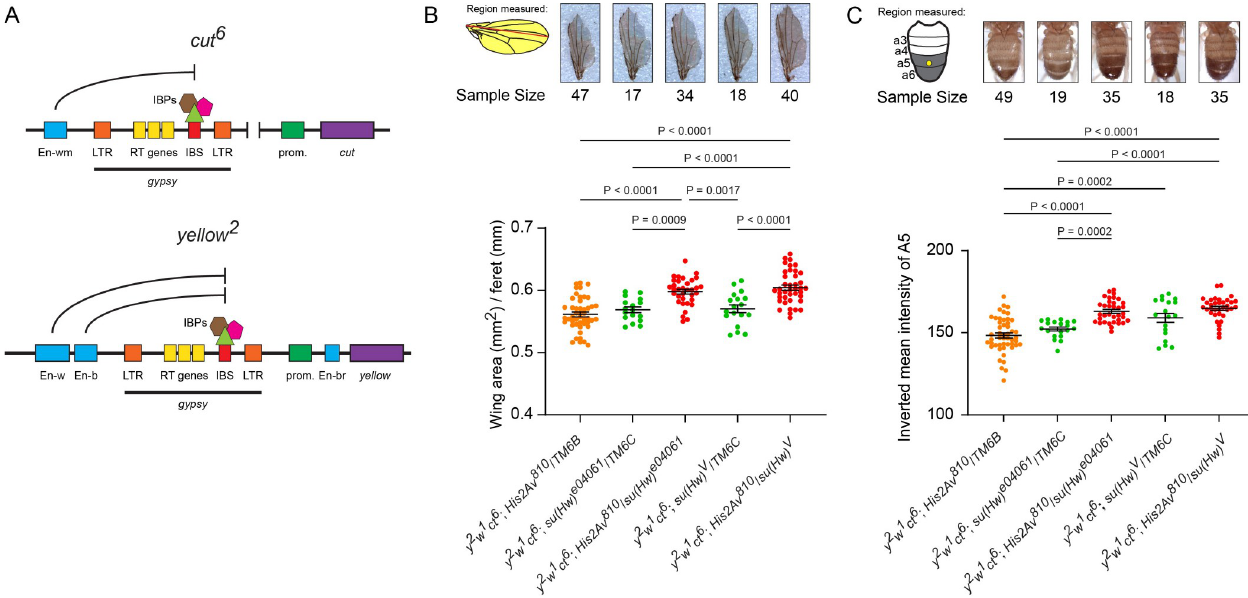
Fig 7. H2Av contributes to gypsy insulator function. A. Illustration of the upstream regulatory elements found in the ct 6 and y 2 alleles. Gene coding sequences (purple) are regulated by coordinated contacts between enhancers (blue) and promoters (green). In each case, the gypsy retrotransposon (denoted with the thick black bar) has been inserted between a promoter and at least one enhancer. LTR = long terminal repeats, RT genes = retrotransposon genes ( gag , pol , and env ), IBS = insulator binding site, IBPs = insulator binding proteins (Su(Hw), Mod(mdg4)67.2, and CP190). When the IBS is bound by a complete insulator complex, it interrupts communication between the promoter and distal enhancers. In cut 6 this prevents expression of cut by the wing margin enhancer (En-wm), while in yellow 2 the insulator prevents expression of yellow directed by the wing enhancer (En-w) and the body enhancer (En-b) but not the bristle enhancer (En-br) between the yellow promoter and transcription start site. Genomic distances are not drawn to scale. B. Wing area in mm 2 (yellow shaded area) was divided by feret diameter (red line). Examples of wings are displayed above their respective genotypes. C. y 2 phenotype scoring in the male abdomen. The illustration on the left shows the male abdomen with abdominal segments 3–6 labelled. A circular ROI (yellow circle) was sampled from the a5 tergite of each male to determine the degree of pigmentation. The graph depicts the mean pixel intensity from individual flies by genotype. Example pictures of abdomens are displayed above their respective genotypes. In B and C , green dots represent su(Hw) heterozygotes arising from each cross, orange dots represent His2Av 810 heterozygotes, and red dots indicate flies doubly heterozygous for His2Av 810 and su(Hw) . Above each data set is the sample size P- values from an ordinary one-way ANOVA performed with Tukey’s multiple comparisons test, with significant differences at P � 0.05. P-values greater than 0.05 are not